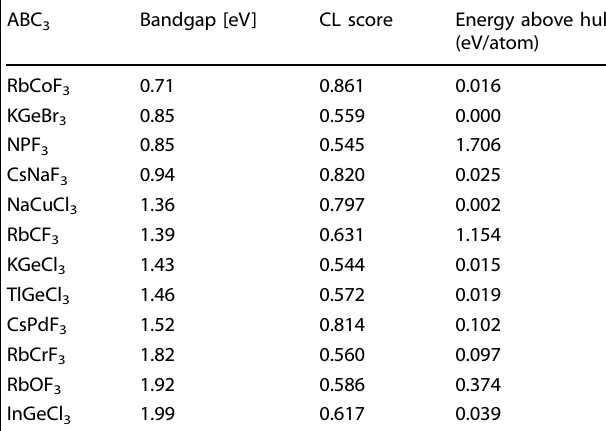
Fig. 5 Predictions of the other methods for the reported virtual crystals. a The distribution of perovskite types for the 179 virtual perovskites found synthesized. The stability prediction of the 179 compounds using the b non-domain-speci fi c MP-trained general model (GCNN + PUL in Fig. 2a), c SISSO-based model 45 , and d Goldschmidt rule-based screening 60 . The ABC 3 perovskites were classi fi ed based on the following criteria: classical perovskites contain cation in A and B site and anion in C site (e.g., SrTiO 3 ), anti-perovskite contains anion in B site and cation in A and C site (e.g., SnNFe 3 ), covalent perovskite contains two or more anions (e.g., CsIO 3 , ClOLi 3 ), and hydride contains hydrogen on the C site (e.g., CaCsH 3 ). Table 1. Synthesizable halide perovskites with calculated bandgap in- between 0.7 and 2.0 eV for photovoltaics